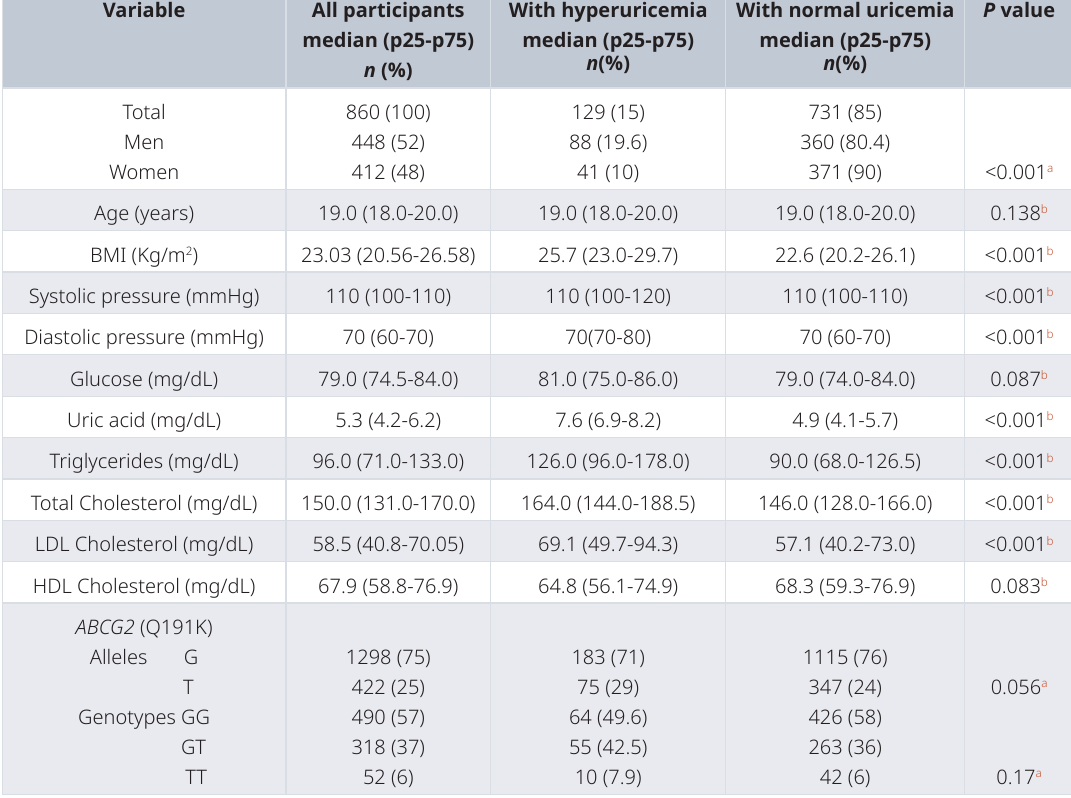
Table 1. Characteristics of the study participants classified by serum uric acid